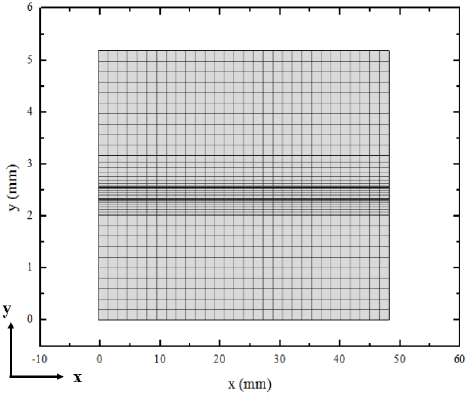
Figure 2. Element independence test for the present mode. ( a ) O 2 mass fraction; ( b ) O 2 side H 2 O mass fraction; ( c ) H 2 mass fraction.